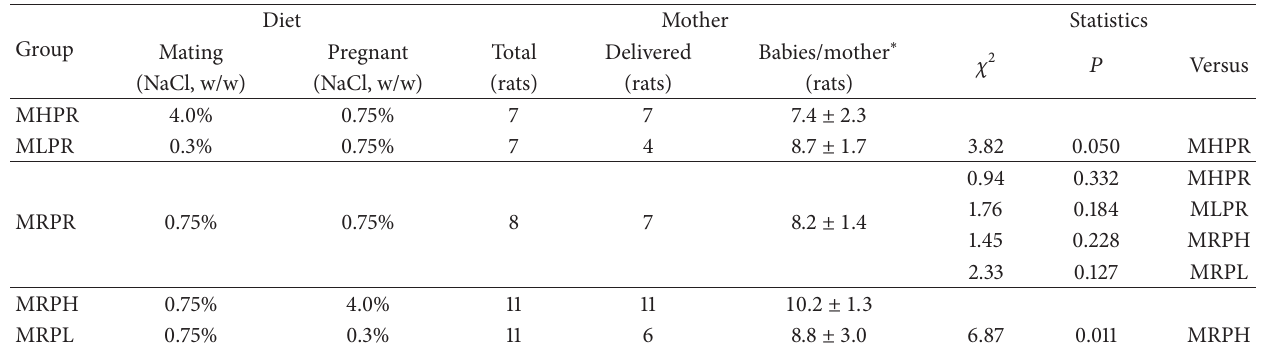
Table 1: Number of mothers that delivered pups.